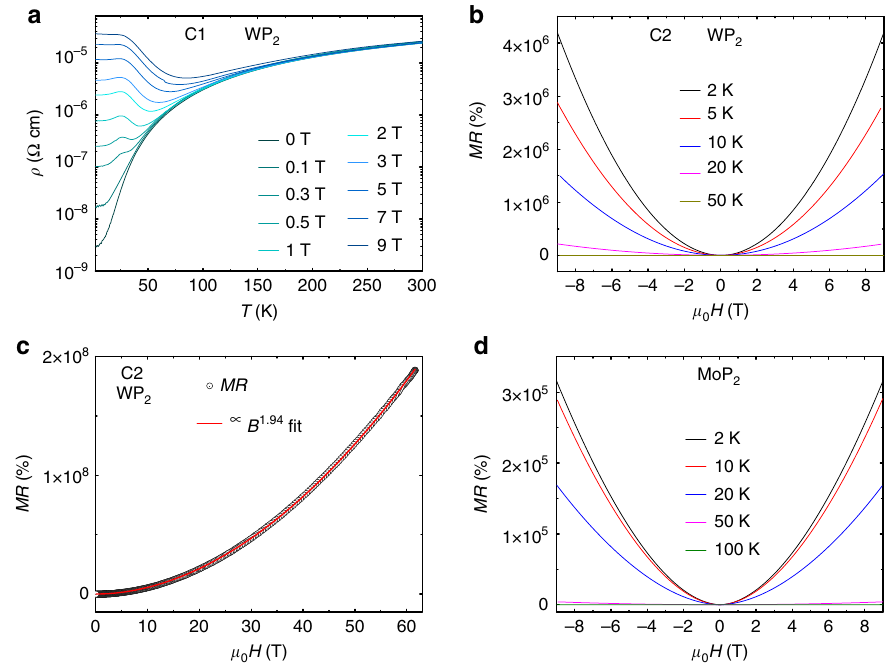
Fig. 2 Magnetoresistance of WP 2 and MoP 2 up to 9 T in static magnetic fi eld and up to 63 T in pulsed magnetic fi eld. a ρ ( T ) data of WP 2 at various magnetic fi elds in a temperature range of 2 – 300 K. b ρ ( B ) data of WP 2 at 2 K and up to 50 K. The highest MR of 4.2 × 10 6 % is observed at 2 K and 9 T. c ρ ( B ) data in a pulsed magnetic fi eld up to 63 T and 2.5 K. The red line shows a near-perfect parabolic fi t of the data up to the highest magnetic fi eld. Extremely large MR of ~ 2 × 10 8 % is observed. d ρ ( B ) data of MoP 2 at 2 K and up to 100 K. The highest MR of 3.2 × 10 5 % is observed at 2 K and 9